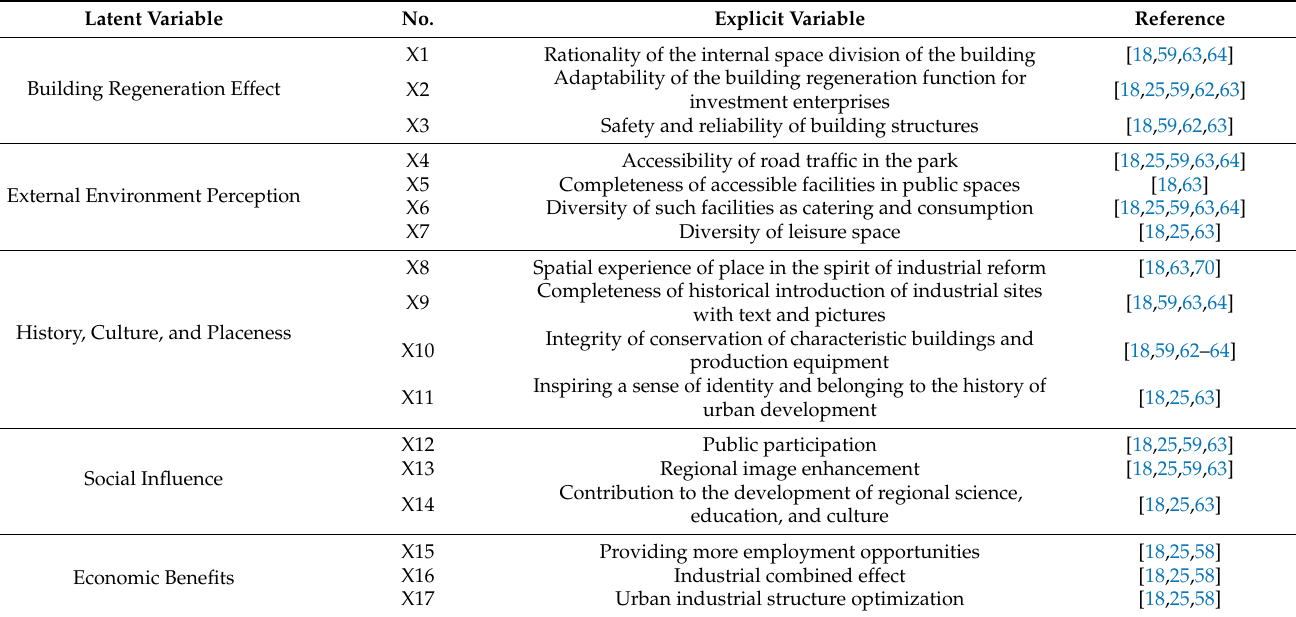
Table 1. Evaluation index system for satisfaction with industrial heritage